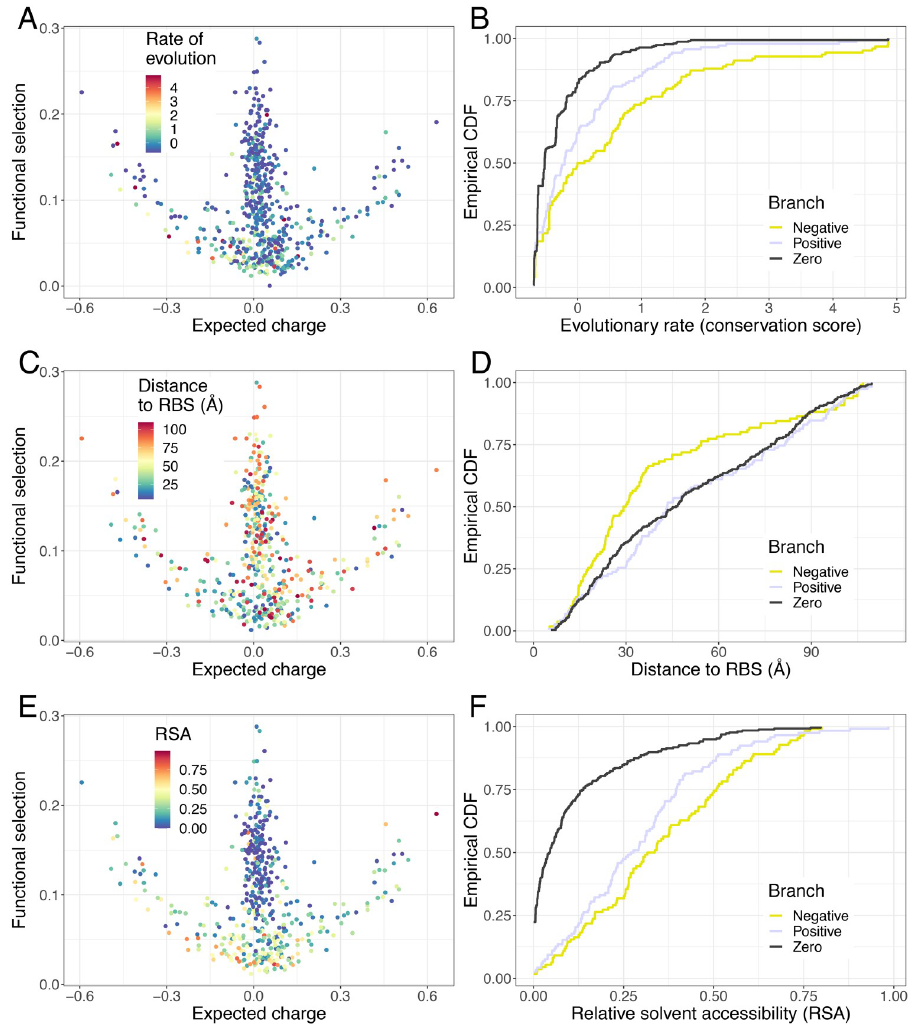
Fig 3. Evolutionary rates, relative solvent accessibility (RSA), and distances to receptor binding site (RBS) on functional branches. ( A ) Normalized conservation scores (labelled rate of evolution) per site overlaid on the functional selection-expected charge plot. These conservation scores were obtained from Rate4site [27] with H1N1 sequences from the fludb database of the IRD [28]. A higher score indicates lower conservation and faster evolution. ( B ) Empirical cumulative distributions of conservation scores for each of the three branches. ( C ) Distances to the RBS overlaid on the functional selection-expected charge plot. These distances were calculated using PyMOL [23] (see Materials and methods) ( D ) Empirical cumulative distributions of the distance to the RBS for each of the three branches. ( E ) Relative solvent accessibility overlaid on the functional selection-expected charge plot. These scores were computed using dmstools2 [29] (see Materials and methods) ( F ) Empirical cumulative distributions of relative solvent accessibility for each of the three branches.